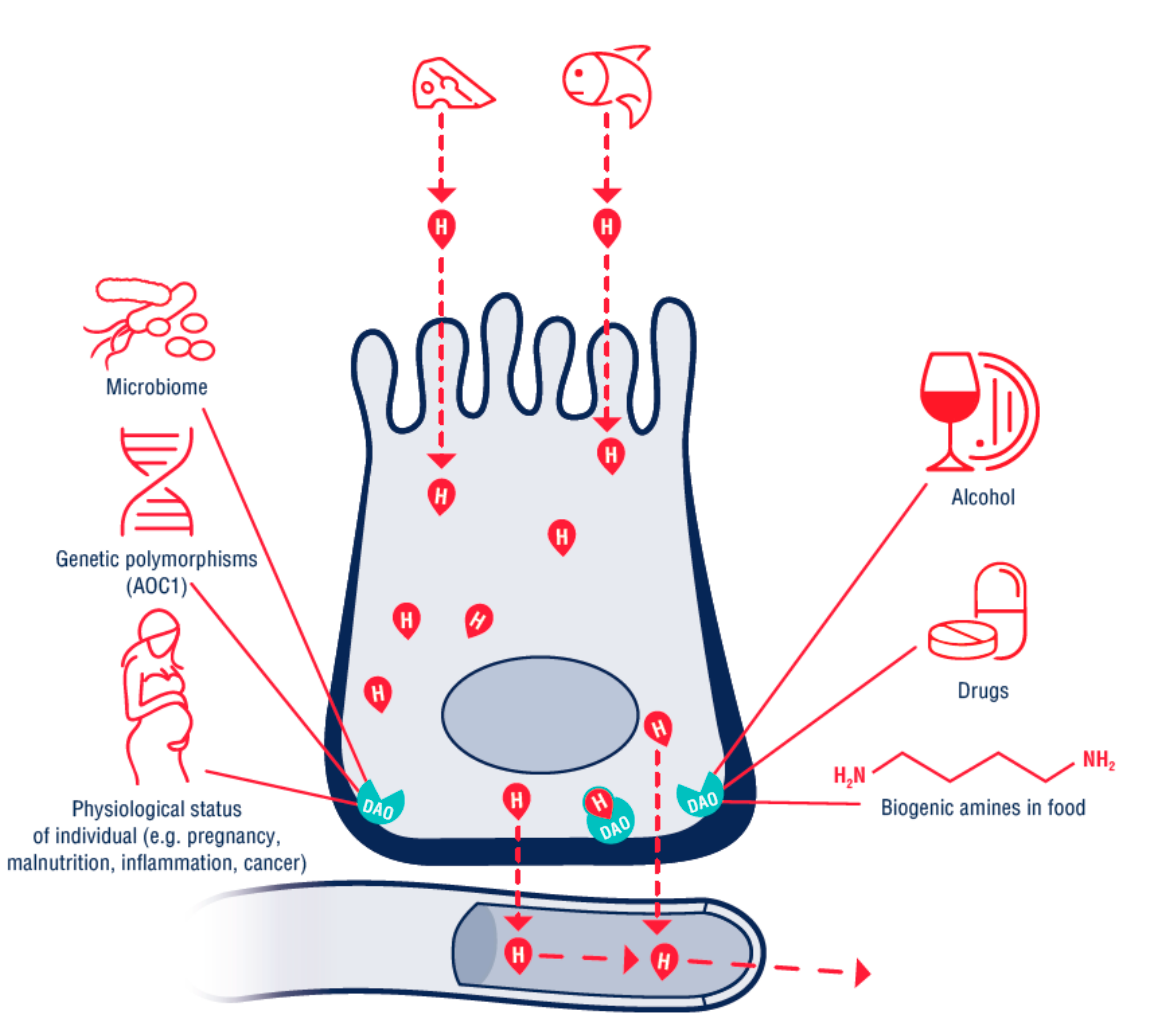
Figure 3. The function of diamine oxidase (DAO) in the enterocyte. The red drop with H shows the histamine released from food. The histamine passes through the enterocyte into the circulation. The DAO enzyme on the basolateral membrane creates a barrier, and the histamine obtained from the food is metabolized (the red drop with H with a green contour). DAO activity is directly/indirectly dependent on internal and external factors such as the polymorphisms of the AOC1 gene, the physiological status of the organism, alcohol, other biogenic amines and medication intake. AOC1—amine oxidase copper containing 1 gene. Table 2. Drugs and substances with possible effects on the metabolism and the distribution of histamine in the organism, which encompass decreasing DAO activity. Adapted according to [13,31–34].